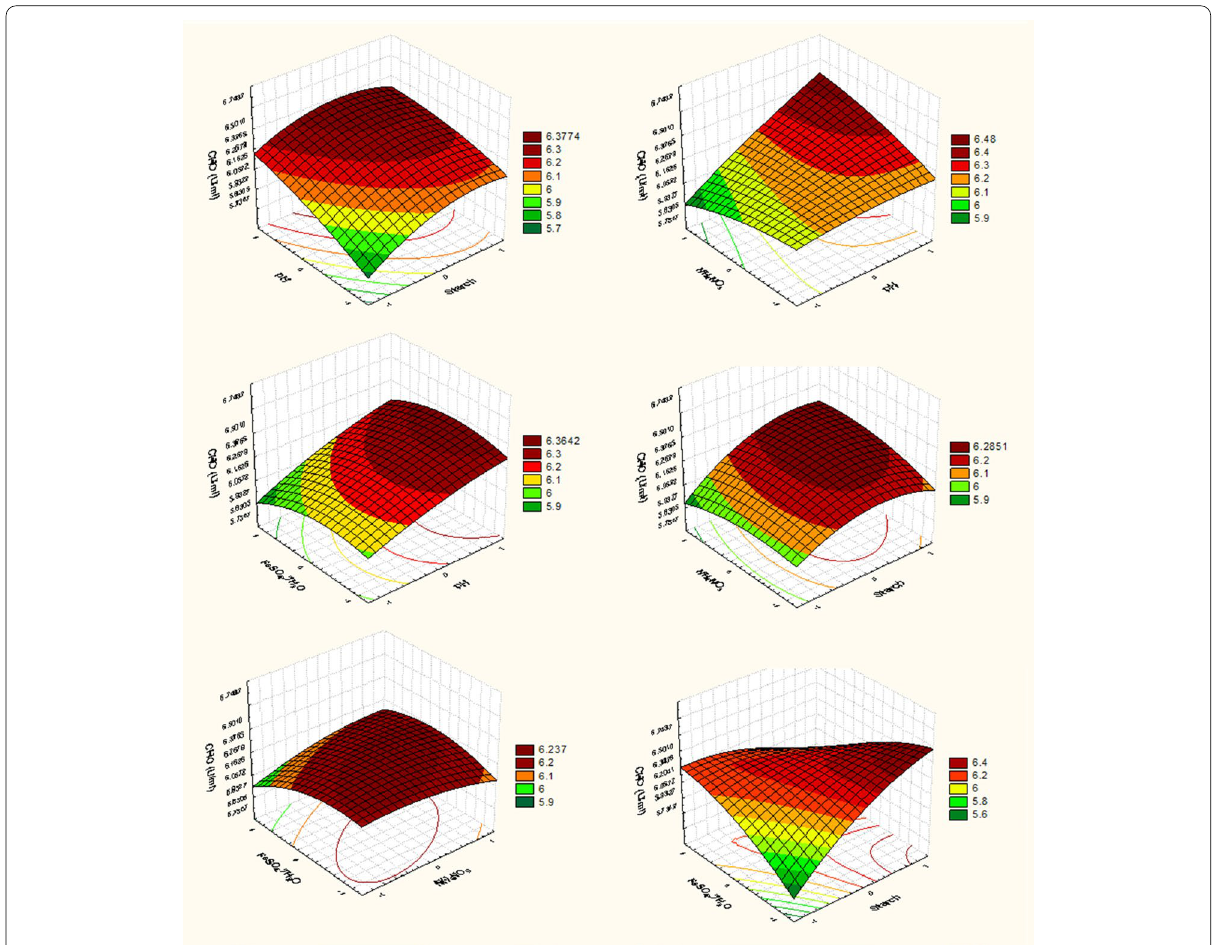
Fig. 4 Three‑dimensional surface and contour plots showing the relationships between the tested variables and the CHO produced by Streptomyces sp. AN